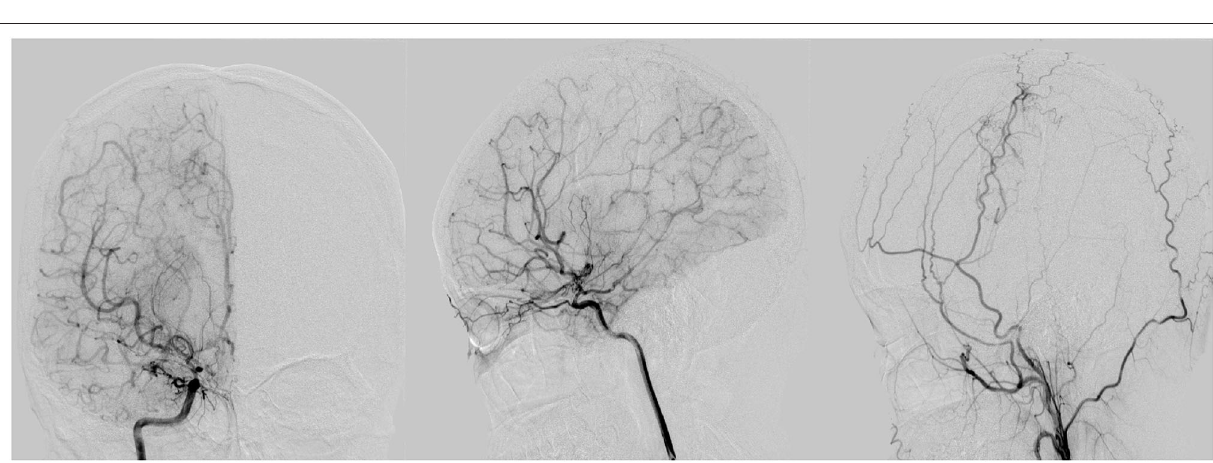
FIGURE 2 | A 34 years old male as G/G genotype showed moderate ischemic condition with a good collateral status (stage III) pre-operatively and surgical collateral circulation showed grade C 3 months after encephaloduroarteriosynangiosis (EDAS) procedure. The three illustrations of digital subtraction angiography (DSA) from left to right is the front view of right internal carotid artery (ICA), the vertical view of right ICA, the vertical view of right external carotid artery (ECA) 3 months after